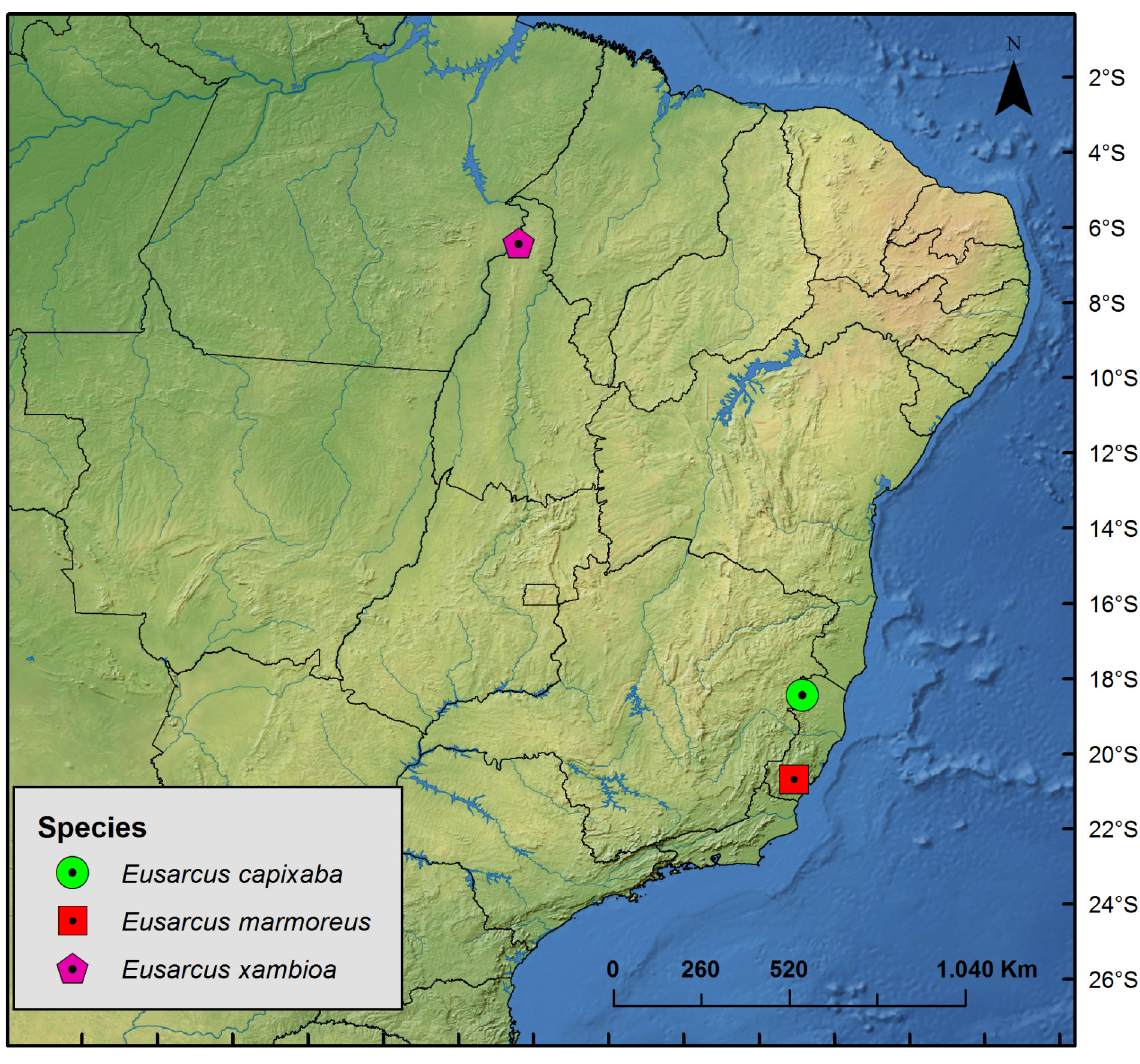
Fig. 11. Known distribution of Eusarcus capixaba sp. nov., Eusarcus marmoreus sp. nov. and Eusarcus xambioa sp. nov. in